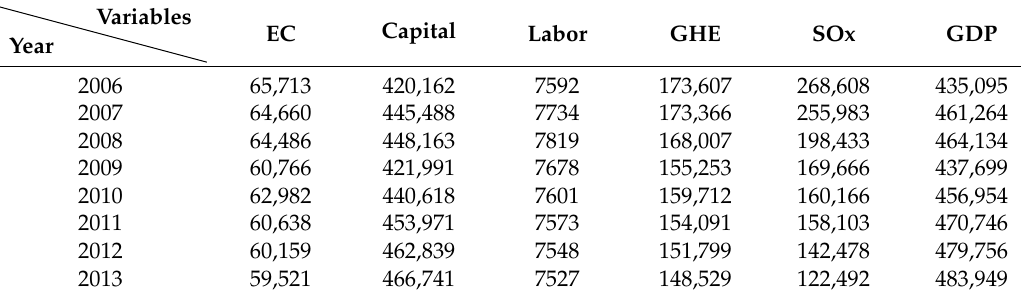
Table 4. AVE value of input and output variables per year for